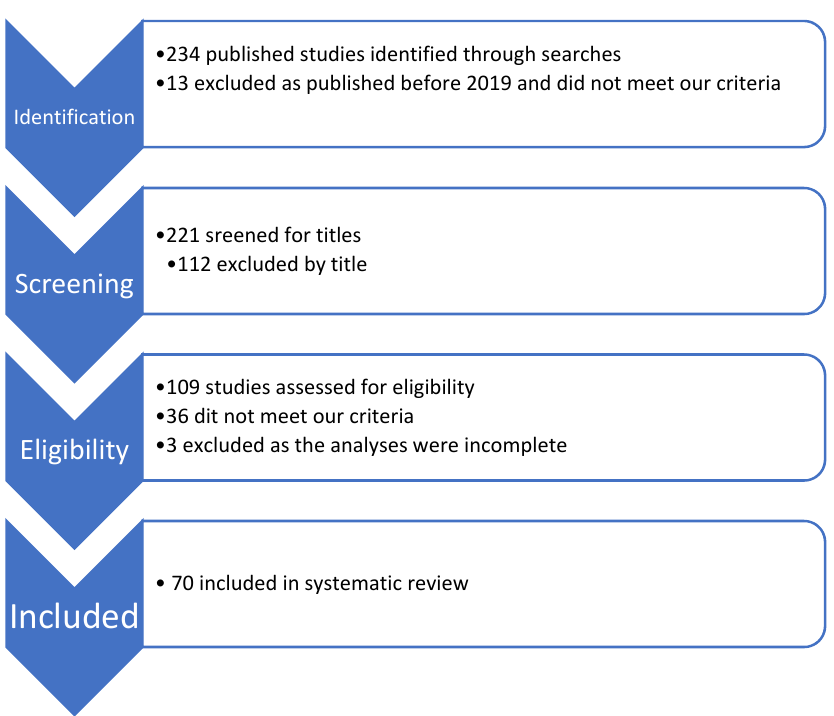
Figure 1. The study’s selection process.